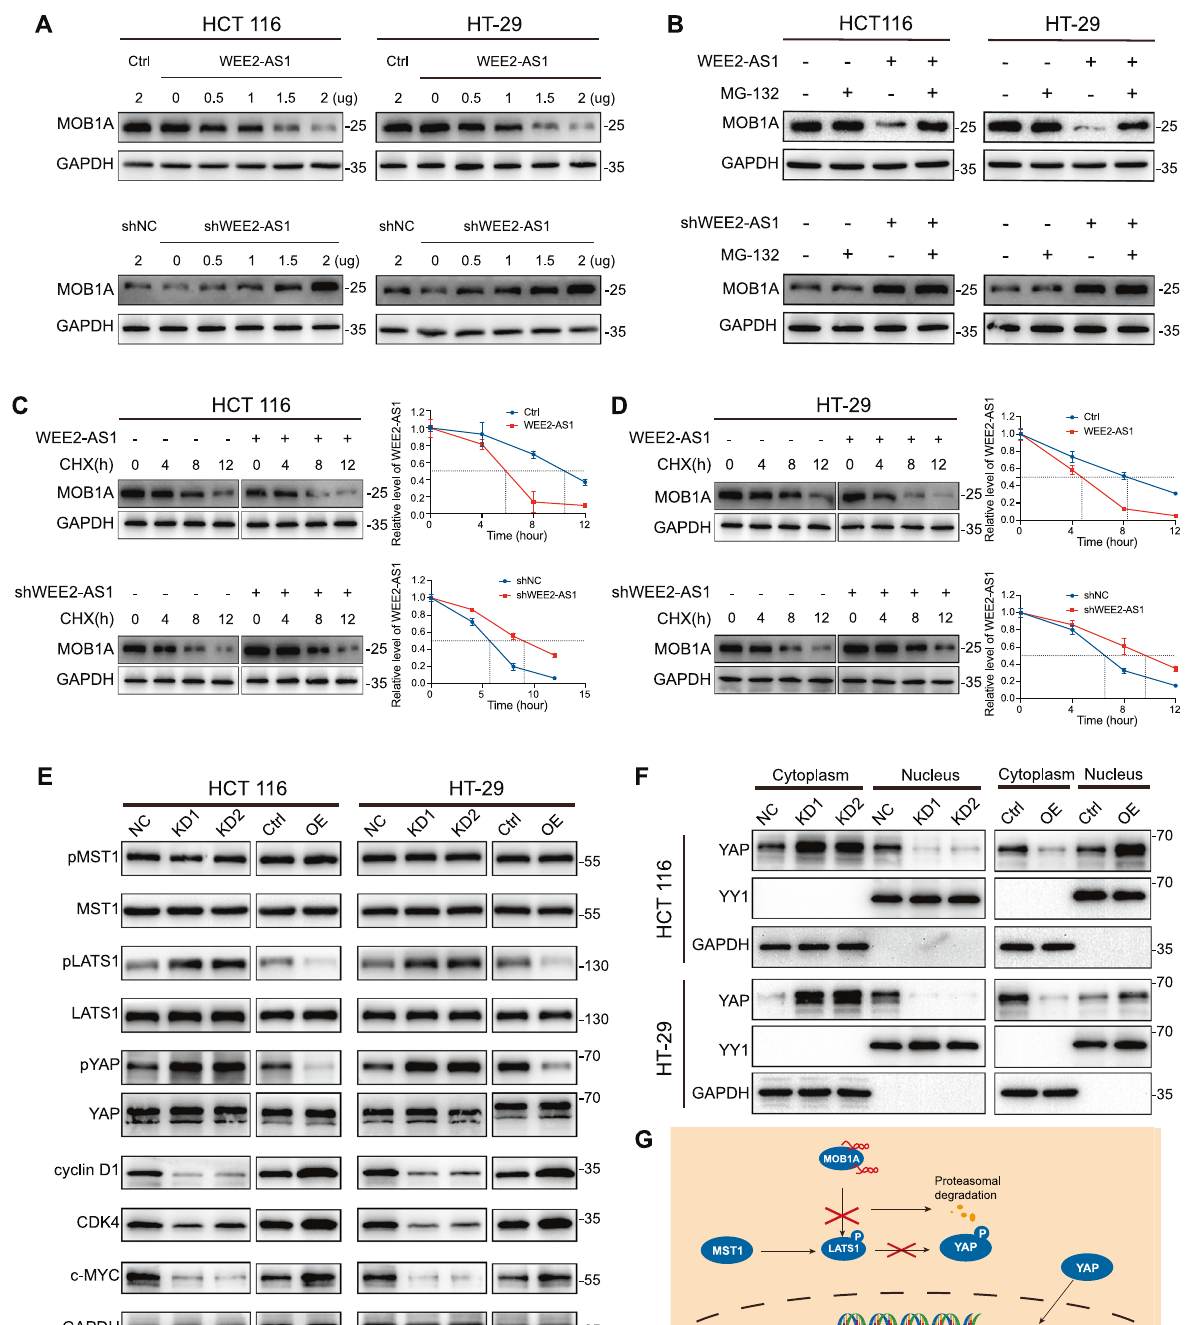
Fig. 5 WEE2-AS1 mediates the proteasomal degradation of MOB1A and inhibits the Hippo pathway. A HCT 116 and HT-29 cells are transfected with increasing amounts of MOB1A overexpression or knockdown plasmids, and endogenous protein levels of MOB1A were determined by WB. B Immunoblotting showing reversion of MOB1A protein levels by proteasome inhibitor MG132 in the WEE2-AS1 knockdown or overexpression HCT 116 and HT-29 cells. C , D Immunoblotting showing the effect of WEE2-AS1 expression changes on MOB1A protein stability in the HCT 116 and HT-29 cells treated with 100 μ g/ml cycloheximide (CHX) for indicated times. E Representative western blot analyses of Hippo signaling pathway factors pMST1, MST1, pLATS1, LATS1, pYAP, YAP, c-MYC, cyclin D1, and CDK4 using speci fi c antibodies through gain or loss of function of WEE2-AS1 in HCT 116 and HT-29 cells. GAPDH acts as an internal reference. F Level of YAP detected by WB in cytoplasmic and nuclear extraction. YY1 was used as a nuclear internal reference, and GAPDH was used as a plasma reference. G Working model for WEE2-AS1 inhibiting the Hippo pathway. Data are shown as mean ± SD of three independent was no change on p-MST1, total MST1, and total LATS1, or total the activation of the Hippo pathway in WEE2-AS1 knockdown or YAP, which indicated that WEE2-AS1 inhibited the Hippo signaling overexpression CRC cells. The results indicated that knockdown of pathway (Fig. 5E). When Hippo signaling is inactivated, YAP/TAZ WEE2-AS1 promoted phosphorylation of LATS1, and YAP, whereas enter the nucleus, bind to the transcription factor TEADs, and WEE2-AS1 overexpression had the opposite effect. However, there